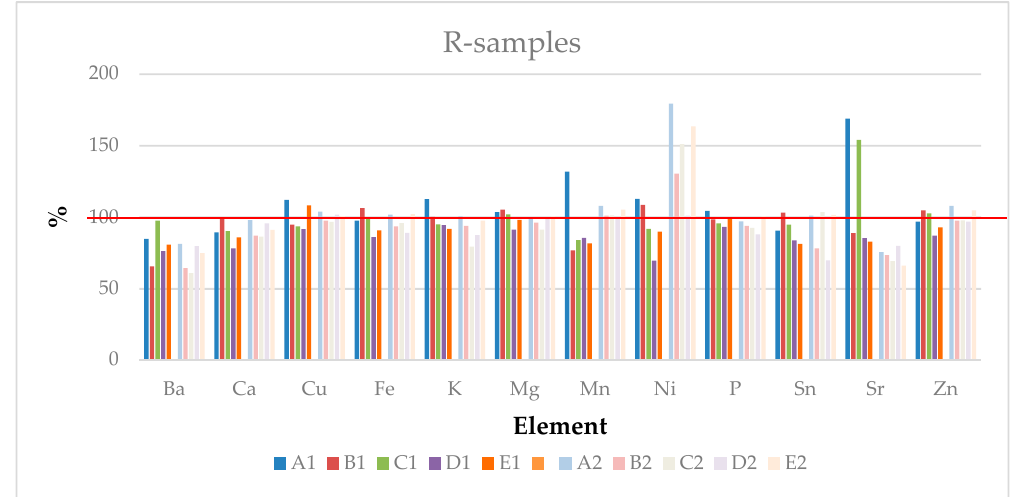
Figure 2. Concentration (%) of each element in the R-samples after four months of storage following the different methods (A–E), expressed with respect to T0 (100%).